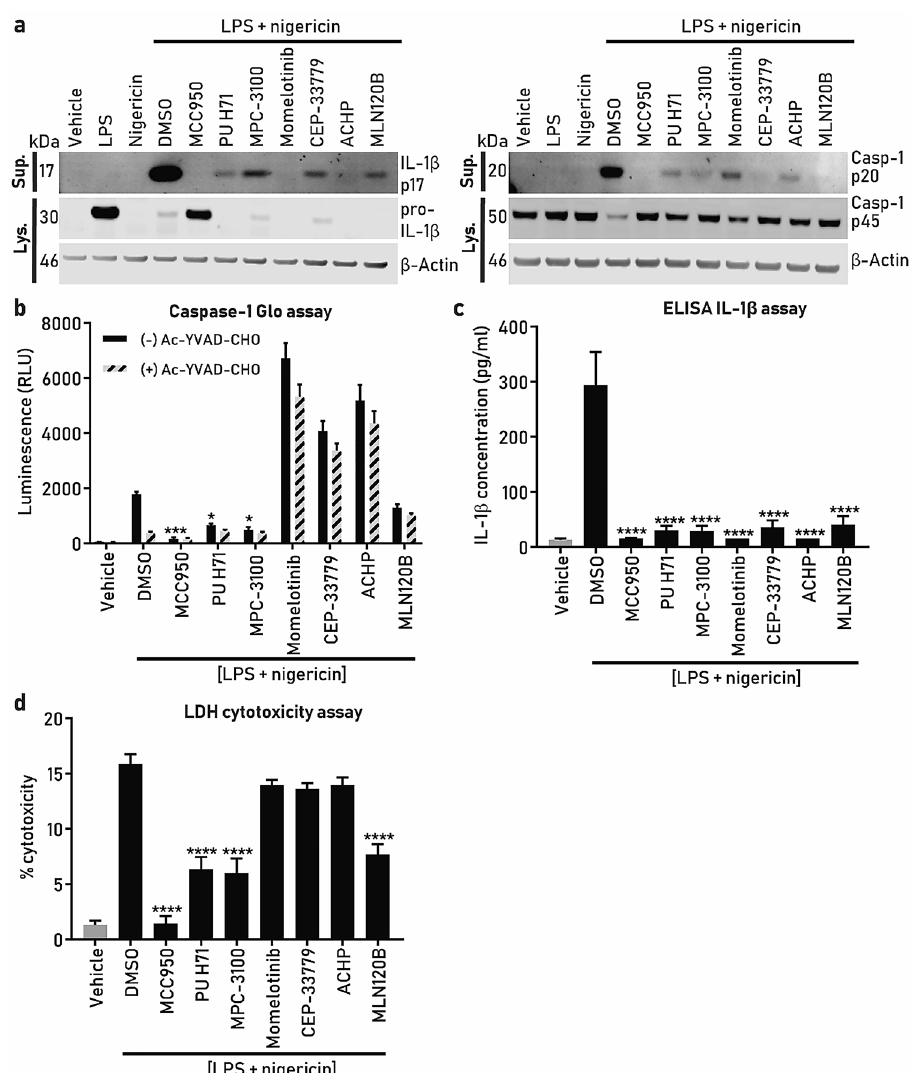
Figure 5. Compound effects on NLRP3 downstream assays (caspase-1, IL1-β, pyroptosis). ASC-mCherry iBMDM were treated with the indicated compounds (10 µM) at the same time as LPS (1 µg/ml, 2 h) and subsequently stimulated with nigericin (10 µM, 2 h). ( a ) Immunoblot of pro-IL-1β and cleaved IL-1β (IL-1β p17), pro-caspase-1 (p45) and caspase-1 (p20) in the cell lysates and supernatants after cell stimulation with LPS + nigericin in the presence or absence of compounds. β-actin was used as a loading control for the cell lysate samples. The IL-1β and caspase-1 bands are cropped from their respective blot images and the full-length blots are presented in Figure S6. ( b ) Caspase-1 activity using Caspase-1 Glo assay with the clear bars are (−) Ac-YVAD-CHO (caspase-1 inhibitor), while dashed lines bar are (+) Ac-YVAD-CHO, ( c ) IL-1β release using ELISA and ( d ) LDH release. In all experiments ( b – d ) data is presented as the mean ± SEM, n = 4 independent experiments and one-way ANOVA with post-hoc Dunnett’s test was utilized to calculate significance, * p < 0.05, ** p < 0.01, *** p < 0.001, **** p < 0.0001. Data in ( b – d ) was analyzed using GraphPad Prism version 7 software (https:// www. graph pad. com/ scien tific- softw are/